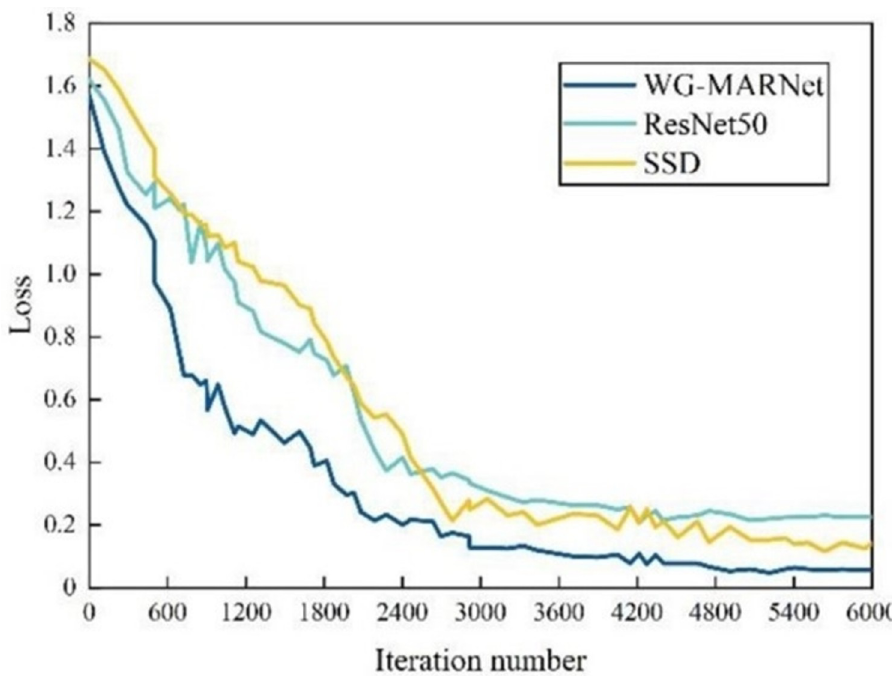
Fig 11. The loss curves of different classification and detection algorithms varying with the iteration